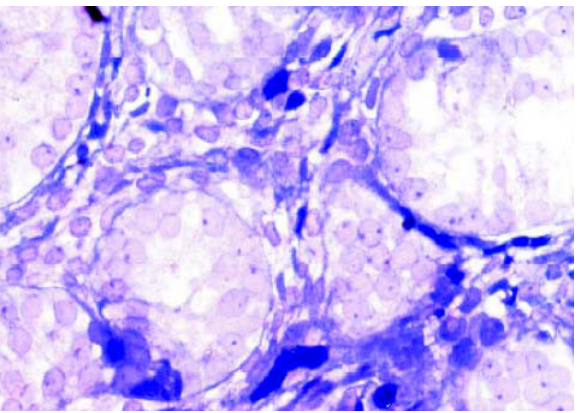
Figure 1 – Photomicrography of testicular parenchyma of a nontreated patient (Toluidin blue, X40).